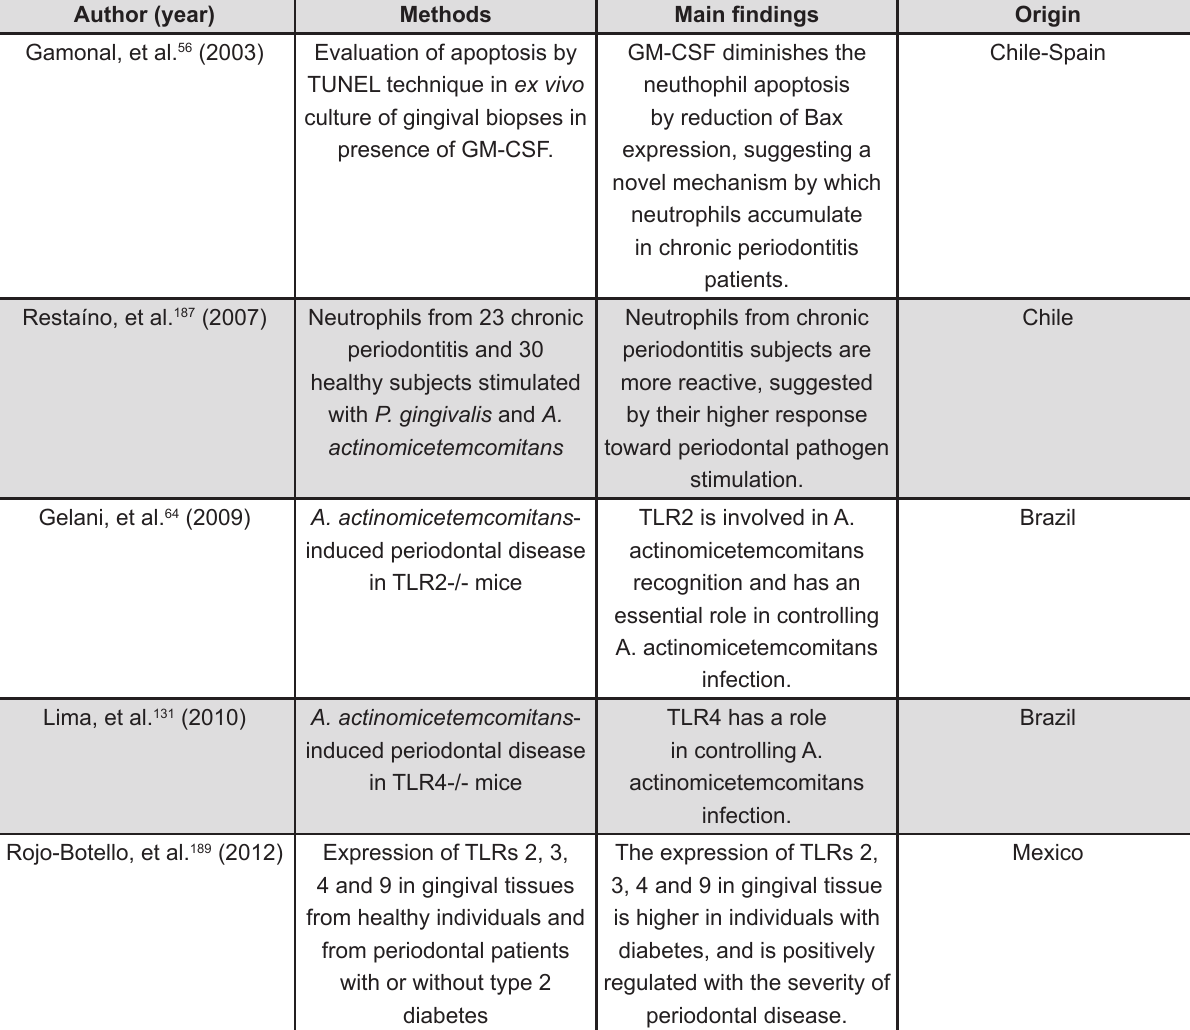
GM-CF: Granulocyte monocyte-colony stimulating